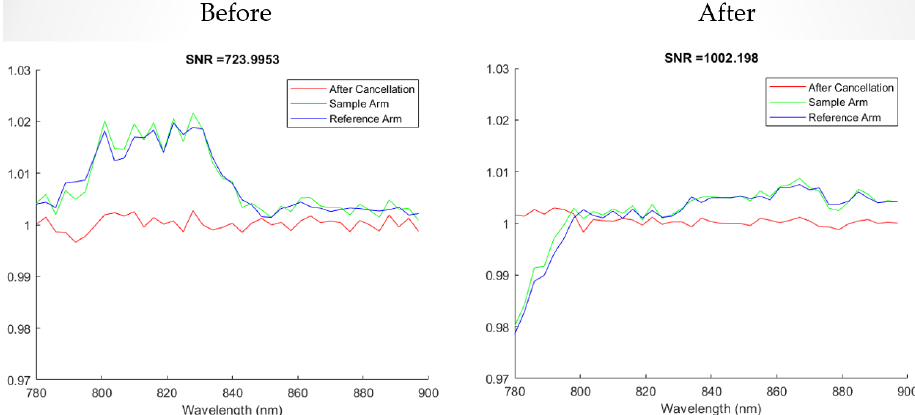
Figure 26. Repeatability comparison before and after moving within building (rolling on brick floor).